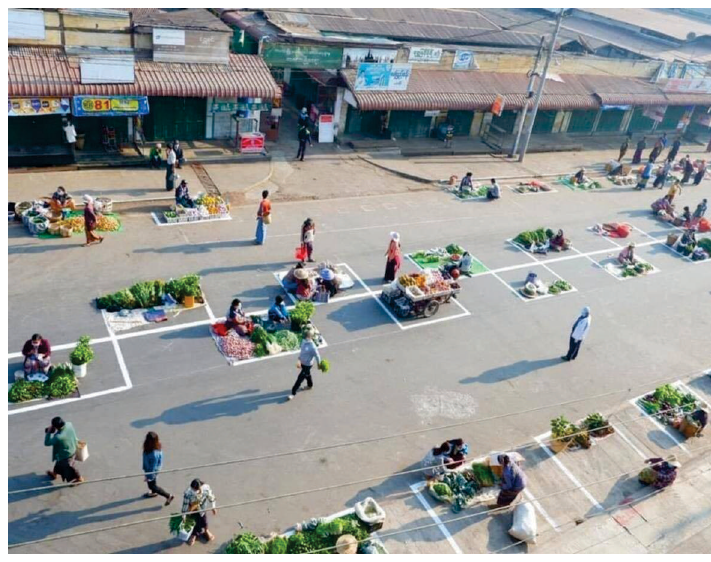
Figure 3: Myanmar model markets with social